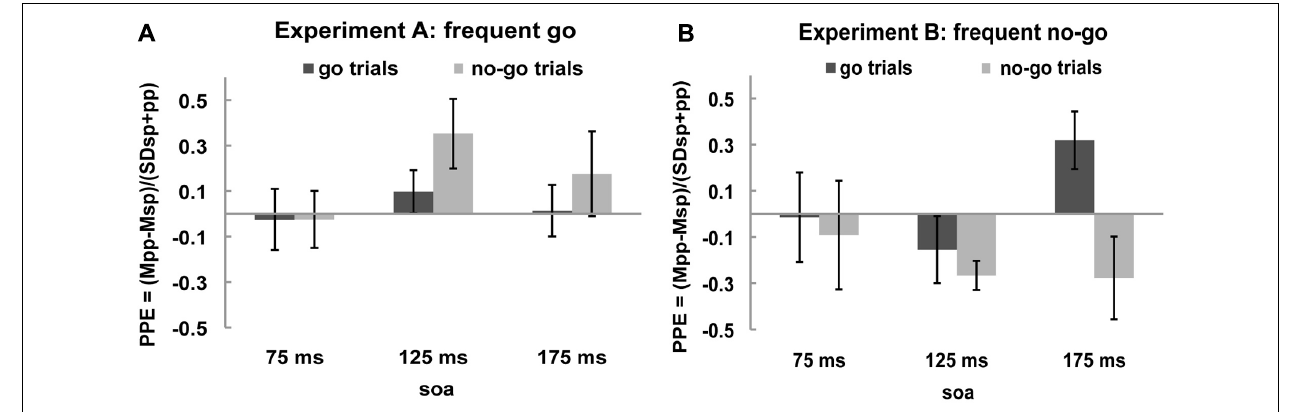
FIGURE 3 | Paired-pulse effect (PPE) no-go trials and go trials. Black bars represent PPE of go trials and gray bars of no-go trials for (A) frequent go experiment and (B) frequent no-go